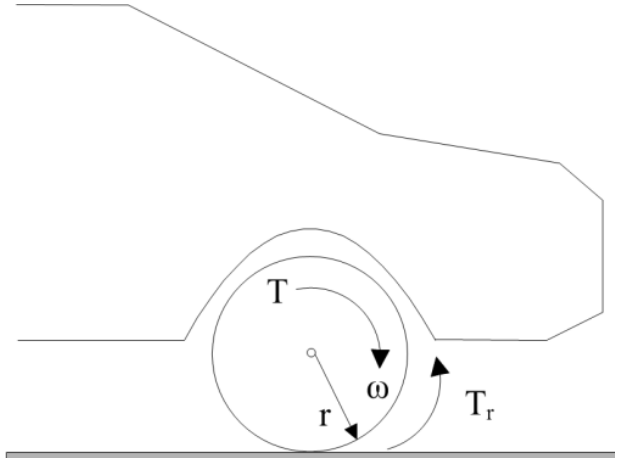
Figure 5. The simplified wheel dynamic